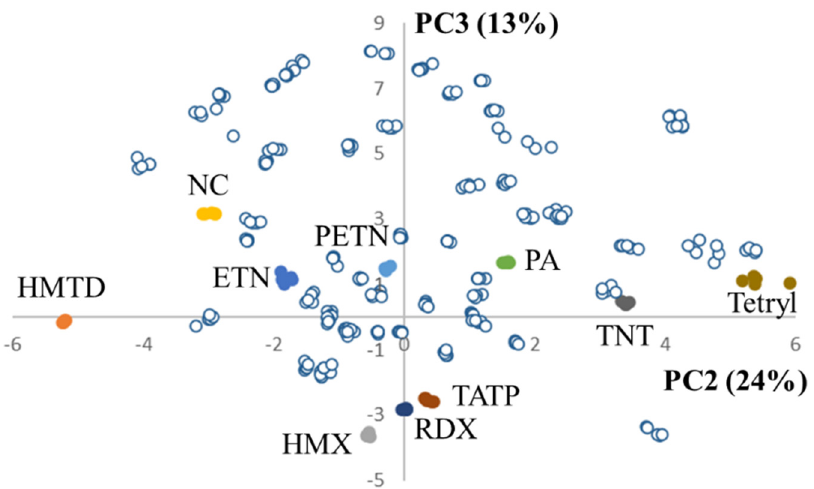
Figure 6. PCA score plot (PC2—explaining 24% of the data variance vs. PC3—explaining 13% of the data variance) of several organic explosives with the negative samples projected in the PCA space (open markers). The PCA model is constructed from a total of 50 NIR reference spectra of 10 organic explosives (excluding the wetted materials), after which a total of 266 spectra of the 51 samples from the ‘negative’ sample set (Section 2.3) were projected in the model.